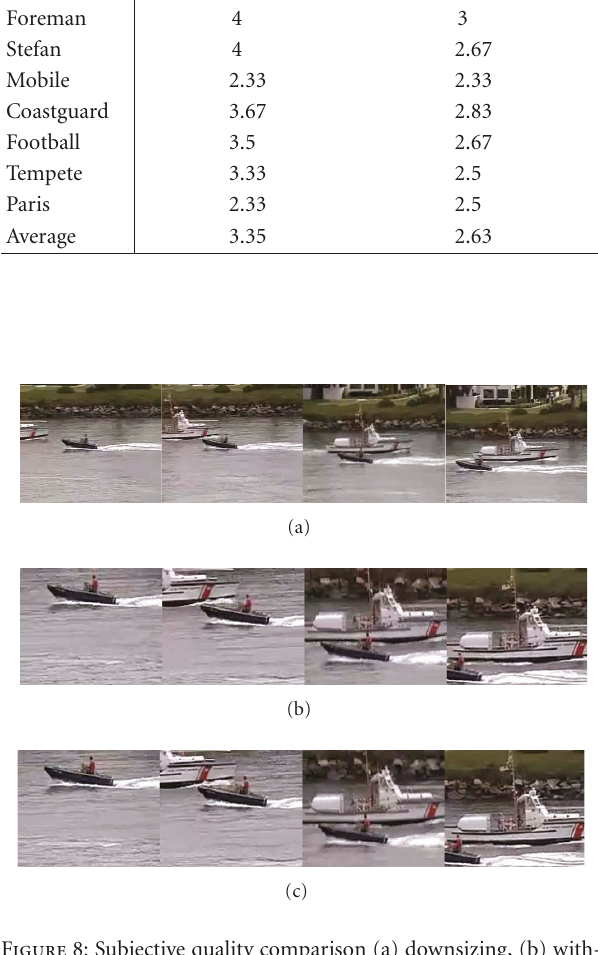
Figure 8: Subjective quality comparison (a) downsizing, (b) with- out QP adjustment, (c) with QP